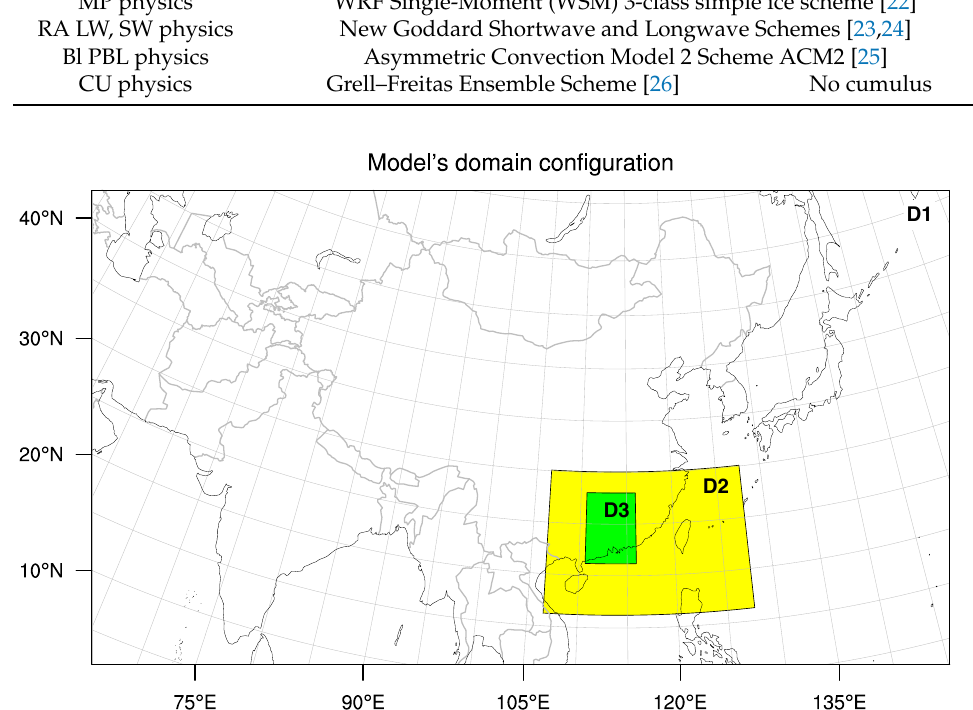
Figure 1. The domain configuration of the model. There are a total of 3 domains with 2 nests. Domain 1 (27 km) is being shown as D1, domain 2 (9 km) is being shown as D2, and domain 3 (3 km) is being shown as